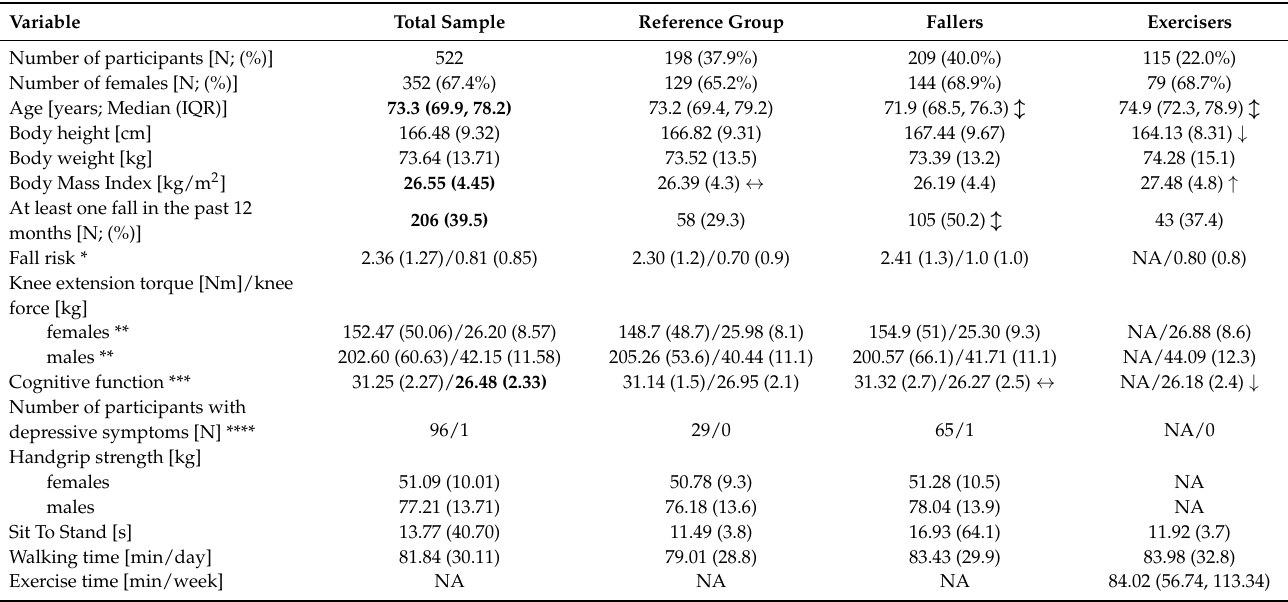
Table 1. Baseline descriptive participant characteristics of the total sample, the reference group, fallers, and